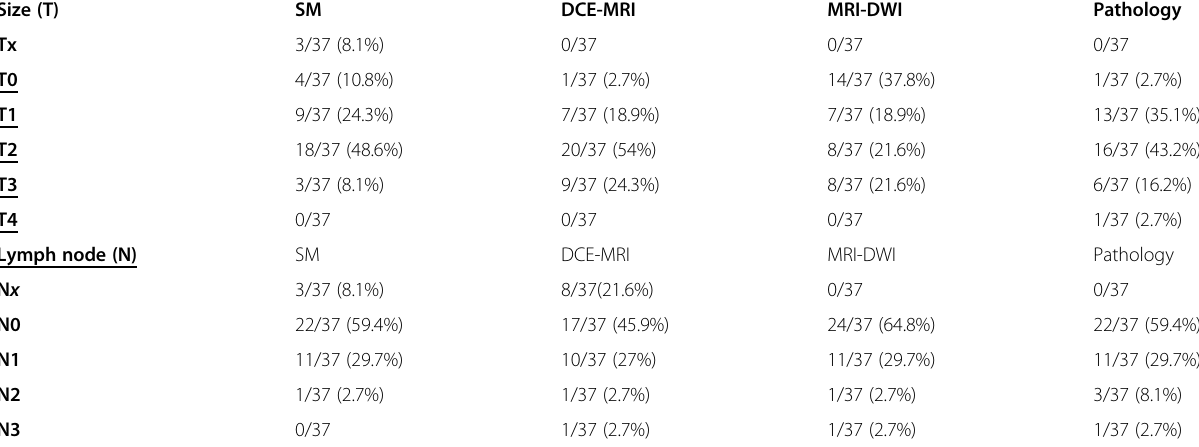
Table 4 Final T and N stages of the cases in the upfront surgery group detected by different imaging modalities Size